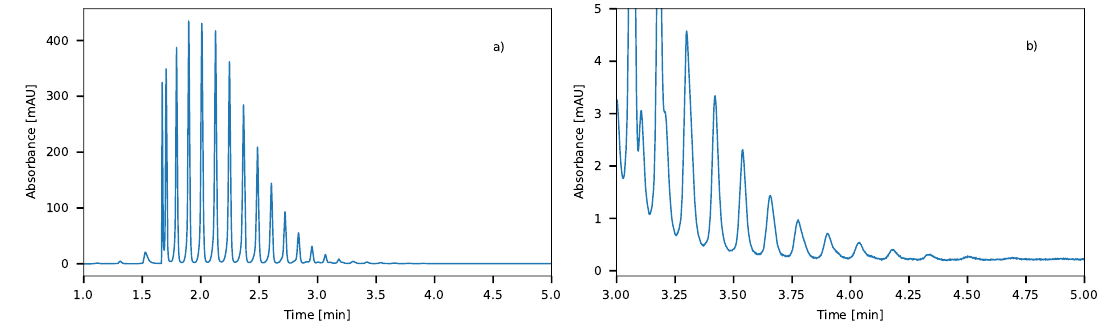
Figure 10. Full ( a ) and zoomed ( b ) chromatograms of Triton X-100 compounds applying a 4-min long gradient ( λ = 200 nm, ∆ ϕ = 0.42 and ϕ 0 =